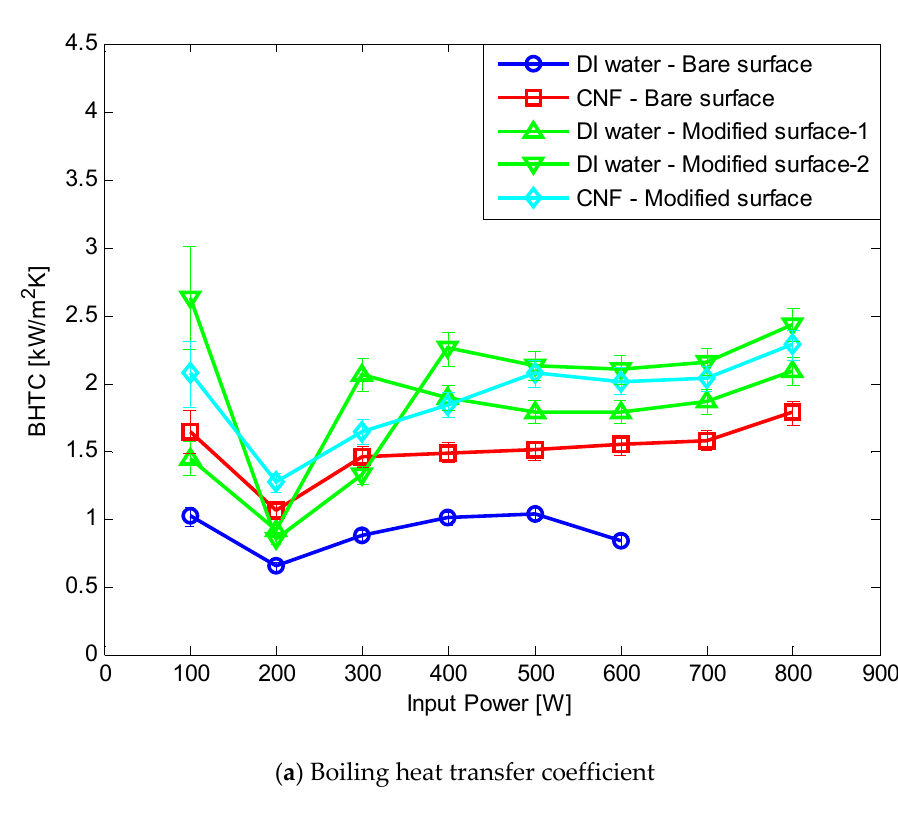
Figure 11. Comparison of experimental results at FR 0.5.